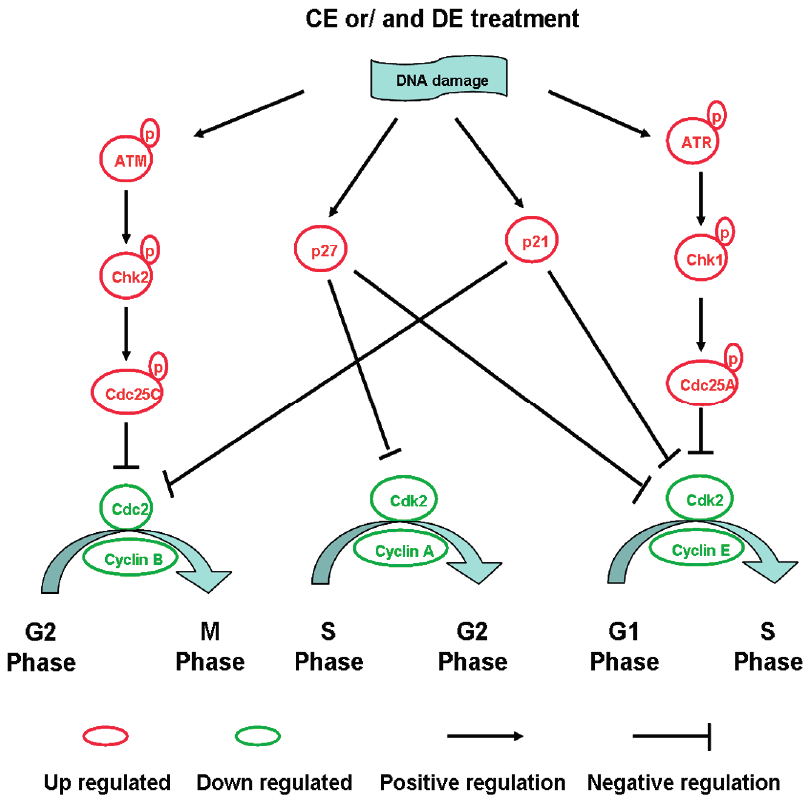
Figure 2. The mechanism of Costunolide (CE) or/and dehydrocostuslactone (DE)-induced cell cycle arrest. CE or/and DE inhibit cell cycle progression mainly through an increase of G2/M phase and S phase. ATM, ataxia telangiectasia mutated; Cdk, cyclin-dependent kinase; ATR, ATM and Rad3-related; Chk, checkpoint kinases; Cdc, cell division cycle